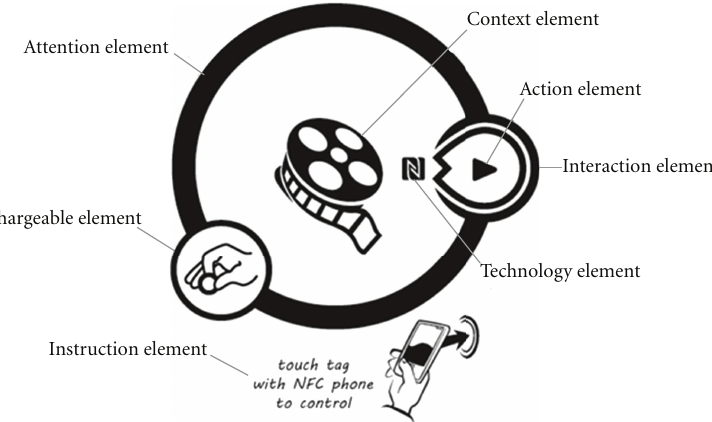
Figure 4: Visual elements of a service advertisement.